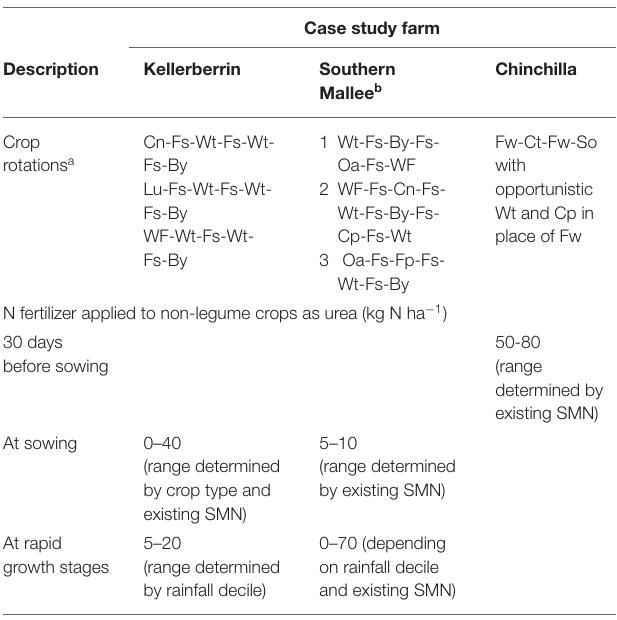
TABLE 2 | Crop rotations and the range of nitrogen fertilizer typically applied, at the Kellerberrin, Southern Mallee, and Chinchilla case study